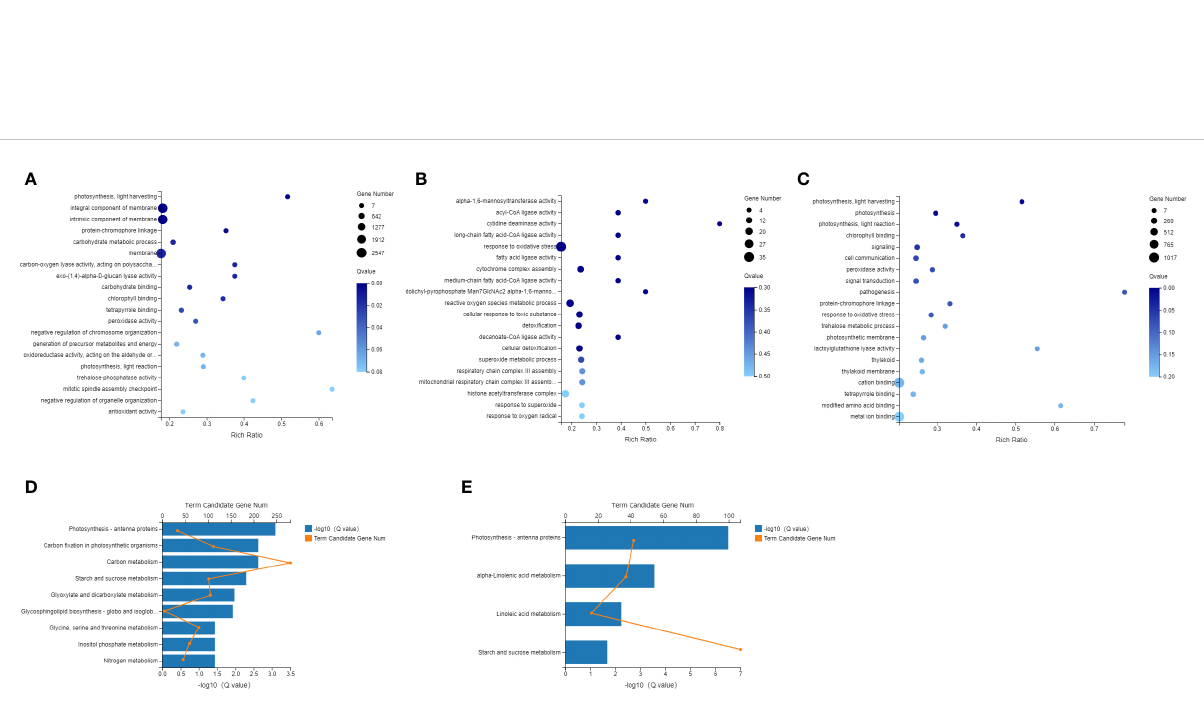
FIGURE 5 Enriched GO terms and KEGG pathway of differentially expressed genes (DEGs) (A) Enriched GO terms of DEGs, Phase II vs Phase I; (B) Enriched GO terms of DEGs, Phase III vs Phase II; (C) Enriched GO terms of DEGs, Phase IV vs Phase IIII; (D) Enriched KEGG pathways of DEGs, Phase II vs Phase I; (E) Enriched KEGG pathways of DEGs, Phase IV vs Phase III.